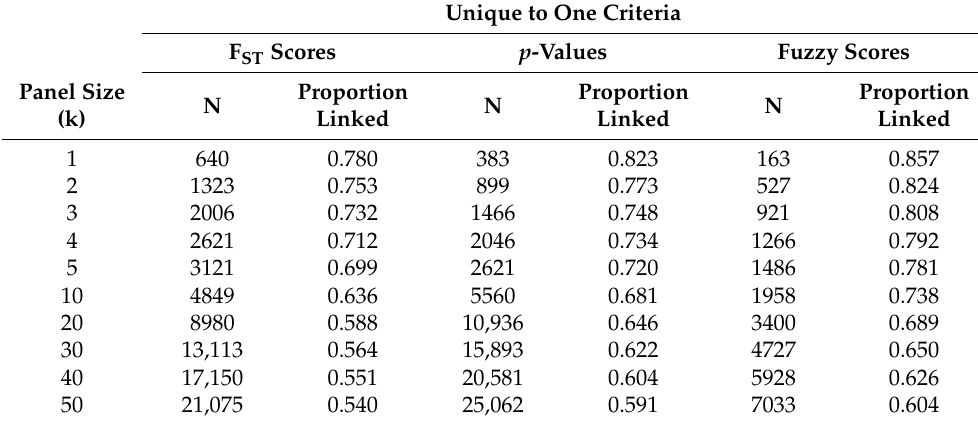
Figure 3. Proportion of SNPs linked with causative variants selected by random, F ST scores, p -values, or fuzzy scores for ( A ) 5 k, ( B ) 1 k, and ( C ) 300 QTL. Table 3. The number of unique SNPs and proportion of unique SNPs that are linked with causative variants for F ST score, p -value, and fuzzy score preselection under a genetic architecture of 5 k causative